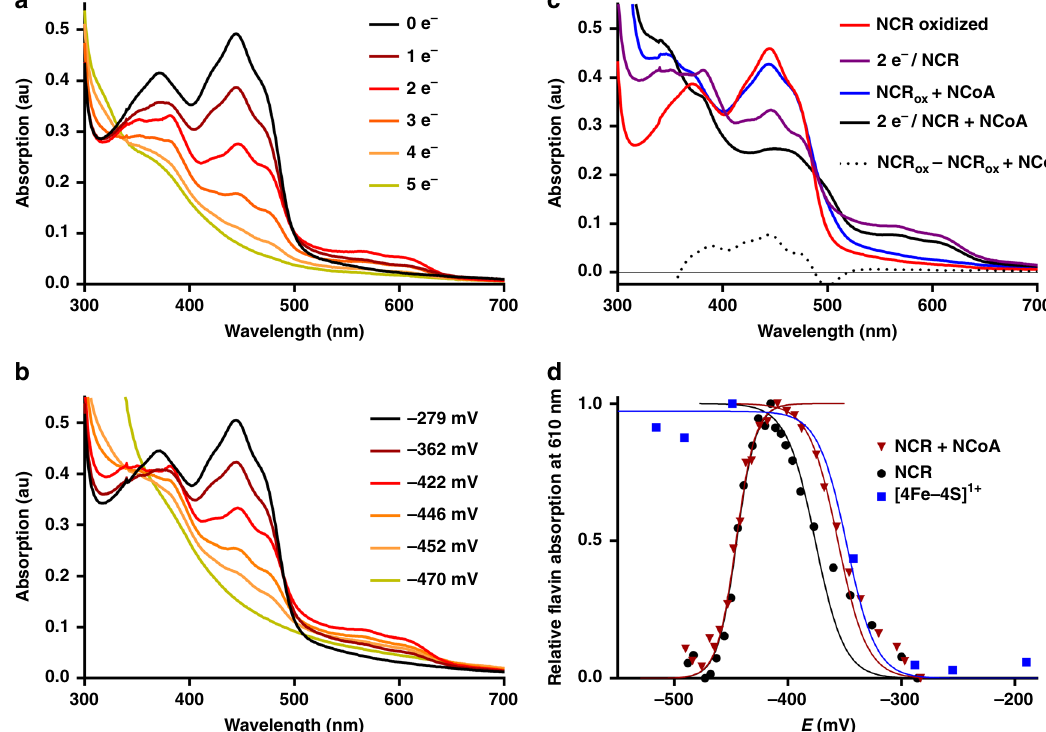
Fig. 6 Titrations of NCR (20 µ M) with dithionite at pH 8. a Absorption spectra after addition of stoichiometric electron equivalents. b Absorption spectra at de fi ned redox potentials. c Absorption spectra of oxidized and two-electron reduced NCR in the absence and presence of NCoA. In the latter the signal of a charge-transfer complex between the substrate and FMN remained that allowed assigning the SQ formation to the FAD cofactor, whereas FMN remained fully oxidized. The dotted line represents the difference spectrum of oxidized NCR without NCoA minus oxidized NCR with NCoA. d Titration of the neutral SQ absorbance spectra of FAD in the absence (black) and presence (red) of NCoA. Formation of SQ/reduction of [4Fe – 4S] was fi tted to a Nernst curve with n = 2 electrons; reduction of SQ with n = 3 due to strong cooperativity of parallel FADH (cid:129) and FMN reduction. Titration of [4Fe – 4S] cluster was followed by its S = 1/2 EPR spectrum (blue). Symbols represent experimental data, solid lines are fi tted curves. R 2 = 0.98 ( + NCoA)/0.78 for SQ formation; R 2 = 0.98 ( + NCoA)/0.99 for SQ reduction. au absorbance units. Source data are provided as a Source Data fi le